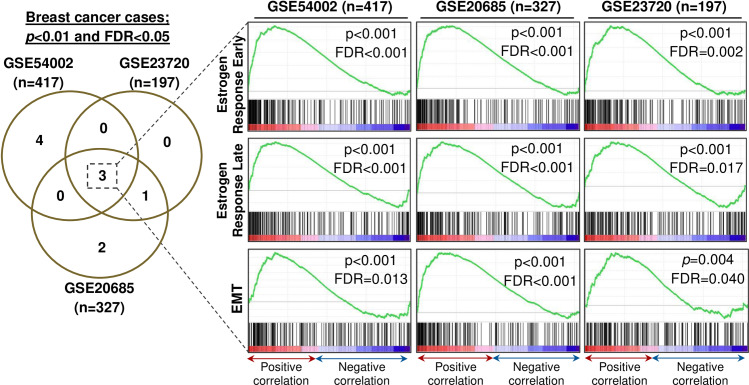
Consensus gene sets (Hallmark collection of the MSigDB) enriched according to TRPM4 expression (219360_s_at) in three independent breast cancer datasets (GSE54002, GSE23720, GSE20685).